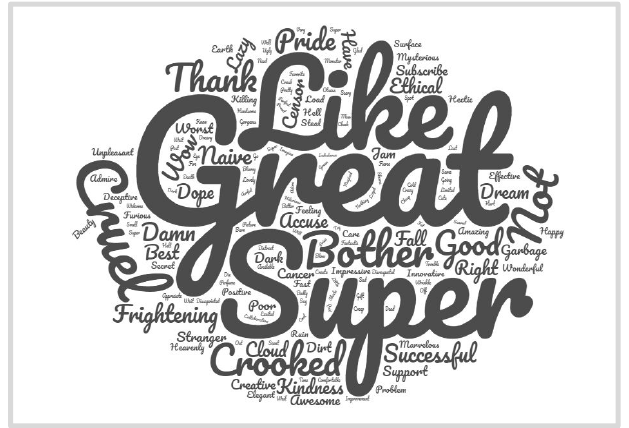
Figure 2. Visualization of the most emotionally charged nouns and adjectives extracted from the totality of the GIF comments.